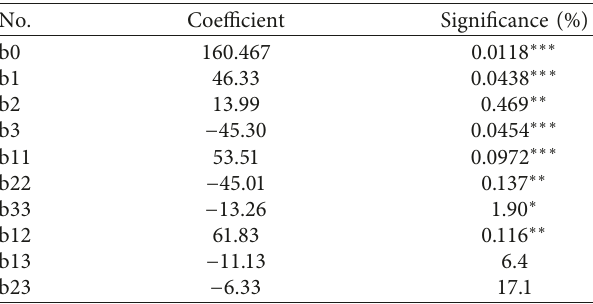
Table 3: Estimated values of coefficients for response Y.